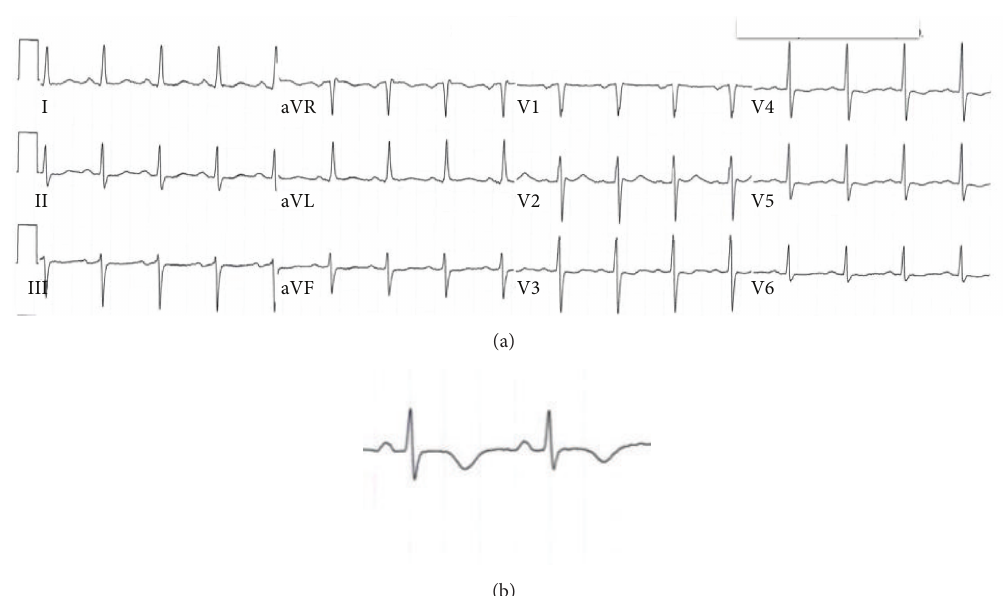
Figure 1: (a) EKG on admission with normal QTc of 446ms. (b) Close-up of lead V2.